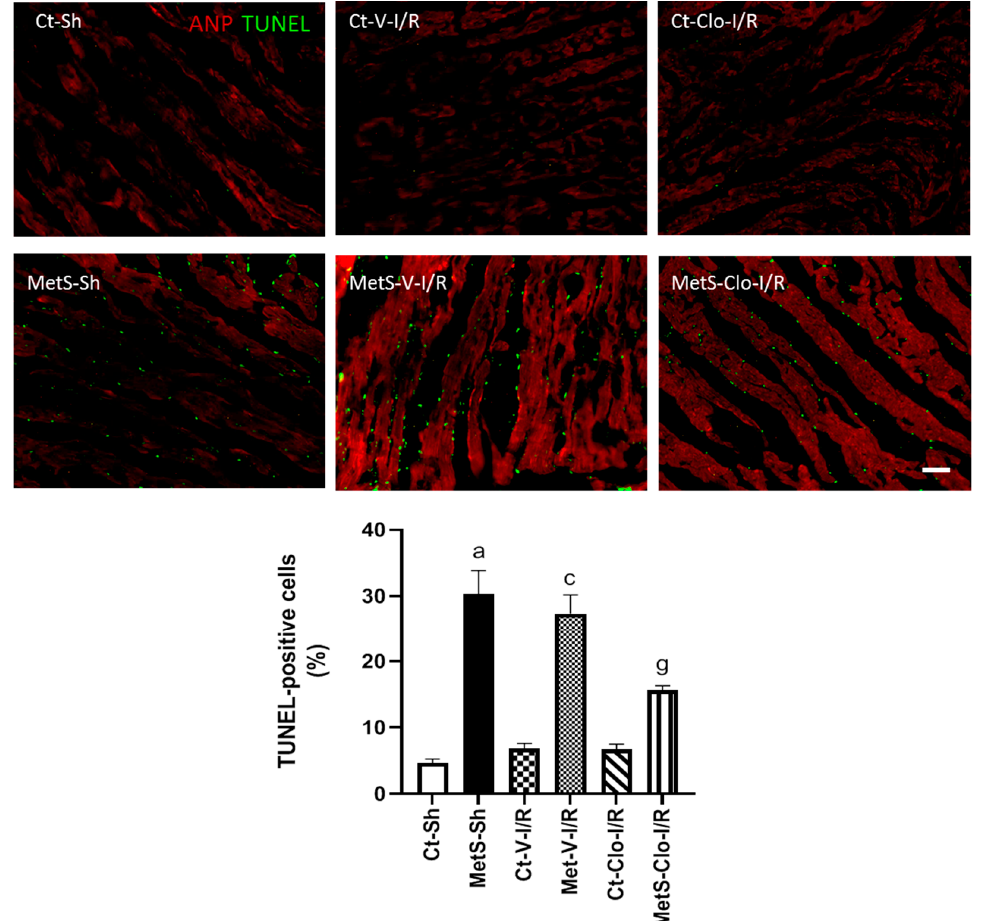
Figure 8. PPAR α agonist treatment decreased apoptosis in ischemic/reperfused (I/R) hearts from MetS rats. The TUNEL assay was performed on cardiac tissue sections previously subjected to ANP immunodetection in red; this facilitates the visualization of positive TUNEL nuclei. The graph with the percentage of TUNEL-positive cells with respect to the total of DAPI-labeled nuclei in each group is presented. a p < 0.0001 vs. Ct-Sh; c p < 0.0001 vs. Ct-V-I/R; g p < 0.0001 vs. MetS-V-I/R. At least 4 fields of each animal (3 rats per group) were quantified, with a total of at least 12–24 determinations. Abbreviations: ANP = atrial natriuretic peptide; Ct = control; MetS = metabolic syndrome; Sh = sham-operated rats; V = vehicle; Clo = clofibrate. Bar = 100 μ m.